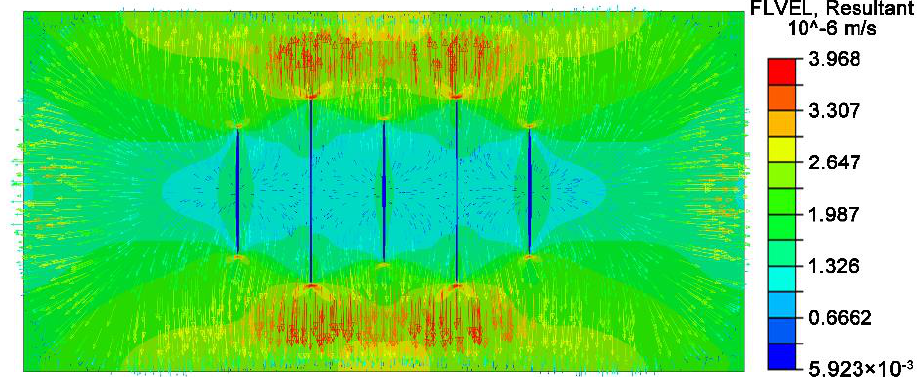
Figure 16. The seepage field after the pump was stopped for 100 min. The fracturing fluid continues to filter out into the formation because the fluid pressure in the fracture is still greater than the pore pressure in the reservoir.